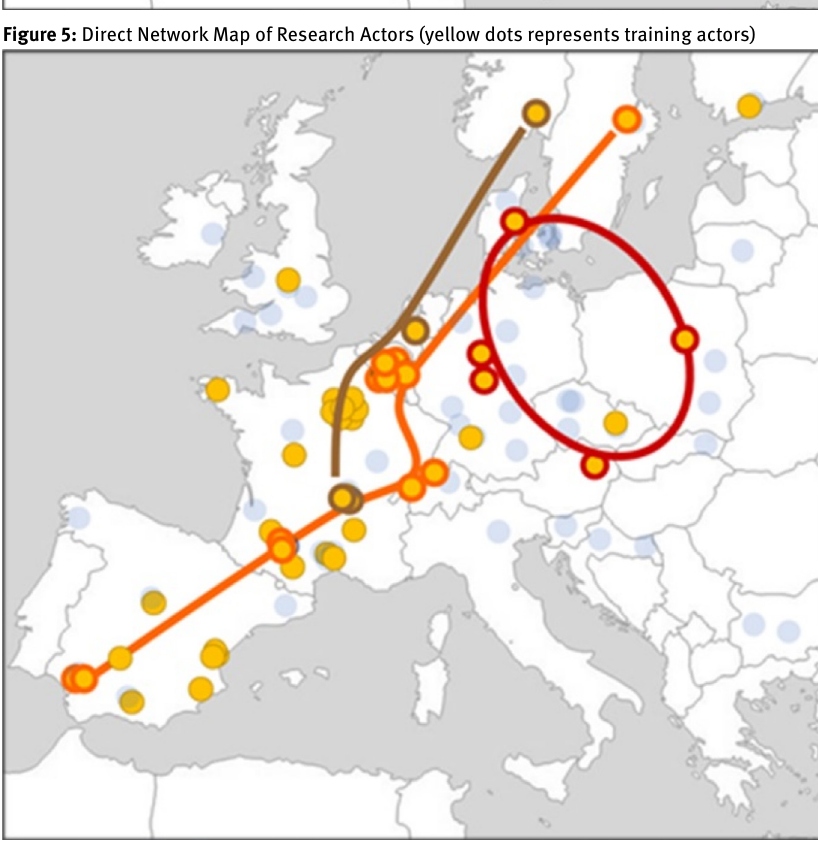
Figure 5: Direct Network Map of Research Actors (yellow dots represents training actors)